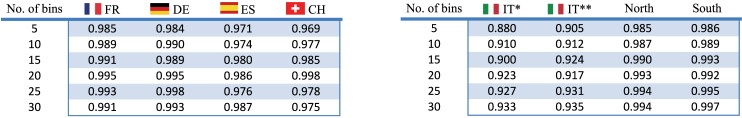
These two tables show values of R
2 coupled to the best fits of data sets MMi,y versus Ωi,y for all the countries considered and for several choices of binning; binned data and best fits are shown in Fig 8.As for Italy, whatever the level of resolution we fix (i.e., whatever the amount of bins we use), the best fit considering the country as a whole (* for the linear fit and ** for the square-root fit) is always significantly worst than the one obtained considering Northern and Southern regions separately.